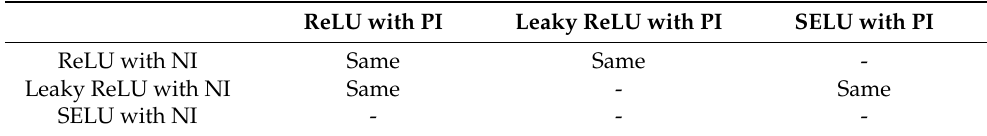
Table 2. Comparison of Peak Patterns for ReLU, Leaky ReLU, and SELU. ReLU with PI Leaky ReLU with PI SELU with PI ReLU with NI Same Same -